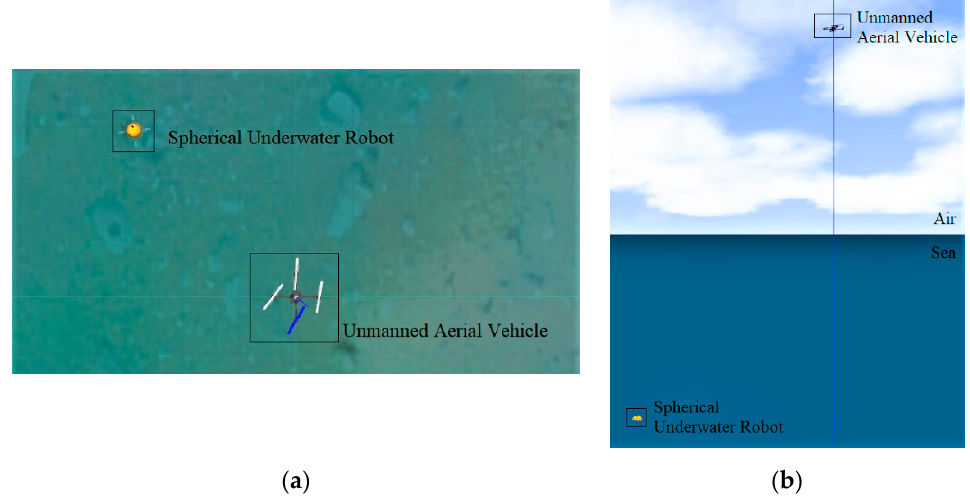
Figure 12. The simulation scenario of underwater robot tracking on the Gazebo platform. ( a ) Top view; ( b ) Elevation view.